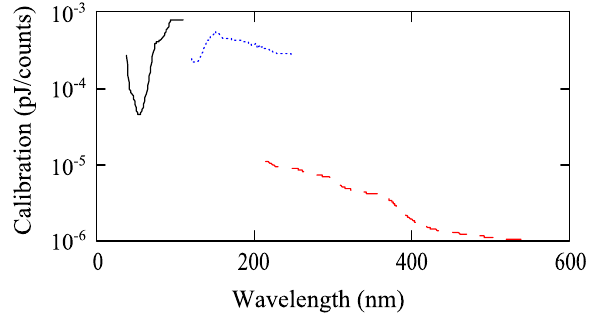
FIG. 8. Energy calibration including the contribution of the CCD detector, the reflectivity of the different gratings. A plati- num coated grating (2400 grooves) covers the short wavelength range (black continuous) and two aluminum coated gratings, 1200 grooves (blue dotted) and 600 grooves (red dashed) cover the middle and long wavelength ranges, respectively.